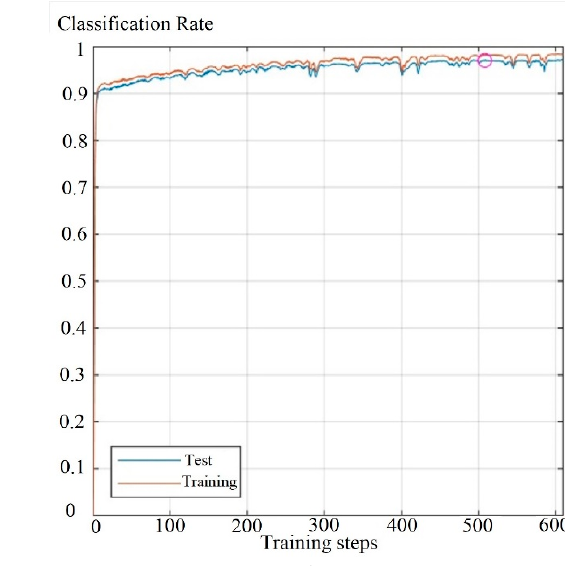
Figure 10. Classification results obtained for a network branch with four cable sections: ( a ) Global classification rate ob- tained during the test and training phase by using a dataset with four frequencies; ( b ) Global classification rate obtained during the test and training phase by applying the principal component analysis to a dataset with 100 frequencies.